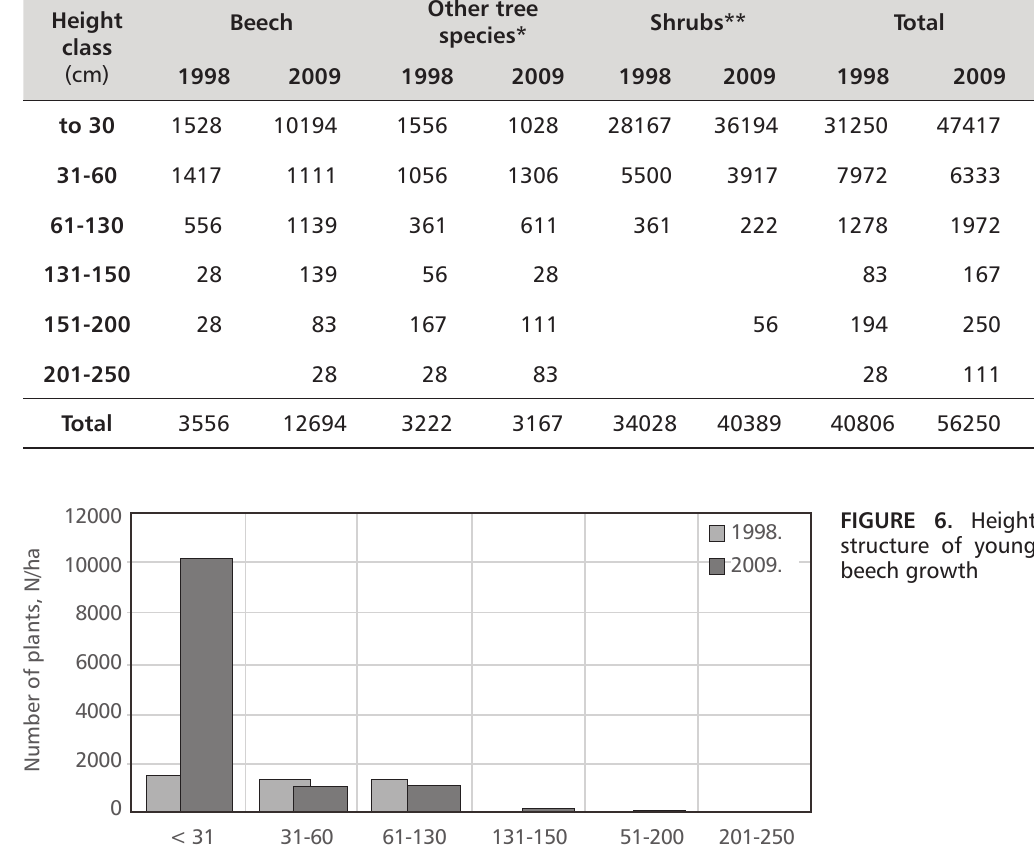
TABLE 2. Number of seedlings, saplings and shrubs per hectare in two measurements * Acer pseudoplatanus L., , Picea abies (L,) H.Karst, Fraxinus excelsior L.